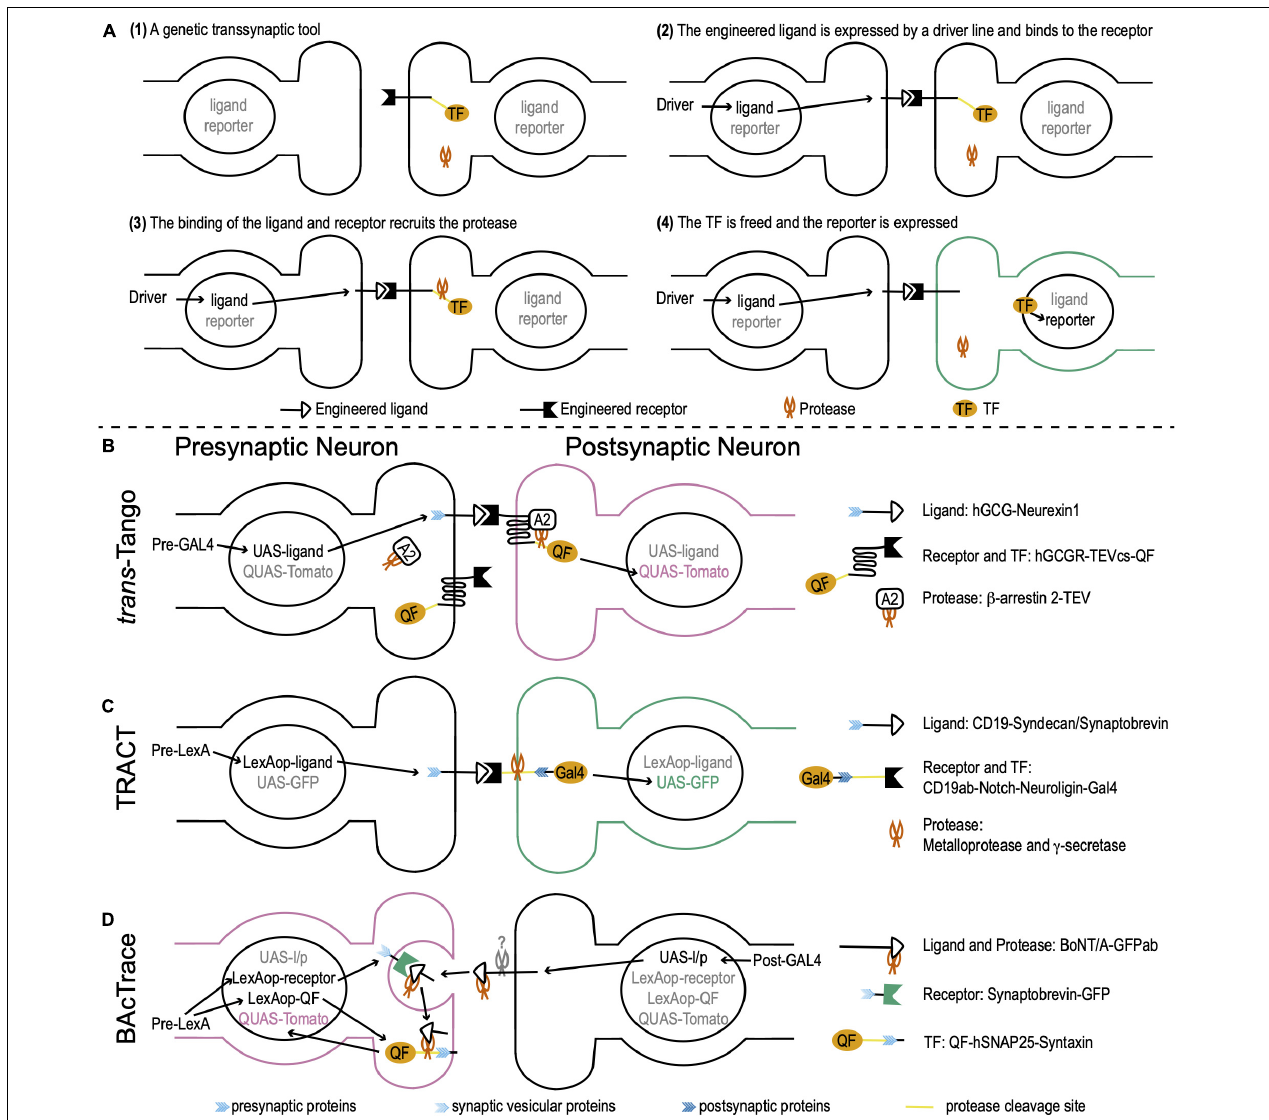
FIGURE 1 | Drosophila genetic transsynaptic techniques. (A) Schematic diagram depicting the principle and process of genetic transsynaptic tools. (1) A genetic transsynaptic tool often includes five components: an engineered receptor, an engineered ligand, a protease, a transcription factor (TF), and a reporter. (2) When a genetic transsynaptic tool is applied, a driver line for neurons of interest drives the expression of the engineered ligand. (3) The ligand binds to the engineered receptor on synaptically connected neurons and recruits the protease. (4) TF is freed and translocates to nuclei, where it activates the expression of the reporter to label synaptic partners. (B) trans- Tango. The receptor is hGCGR. The ligand is hGCG. The ligand is linked to Drosophila neurexin 1 (blue feather) for the presynaptic localization. The protease is TEV. It is tethered to β -arrestin 2 (A2) ( β -arrestin 2-TEV). The TF is QF. QF is tethered to the C terminus of receptor by a cleavage site of TEV (TEVcs) (yellow line). The reporter is Tomato that is controlled by QUAS ( QUAS-Tomato ). The receptor, TF, and protease are panneuronally expressed (the DNA information is not shown), while the ligand is controlled by UAS ( UAS-ligand ). Activation of trans- Tango requires a presynaptic GAL4 ( Pre-GAL4 ). (C) TRAnsneuronal Control of Transcription (TRACT). The receptor includes a CD19 antibody (CD19ab), the Notch regulatory region and transmembrane domain (yellow line), and the cytosolic domain of Drosophila neuroligin (dark blue feather) for postsynaptic localization. The ligand is CD19, whose C terminus is linked to the cytosolic domain of either syndecan or synaptobrevin (blue feather) for presynaptic localization (CD19-Syndecan/Synaptobrevin). The proteases are ubiquitously present metalloprotease and γ -secretase (the DNA information is not shown). They cleave the receptor at the Notch regulatory region and transmembrane domain. The transcription factor (TF) is GAL4 that is tethered to the C terminus of the receptor. The reporter is GFP controlled by UAS ( UAS-GFP ). The receptor and TF are panneuronally expressed (the DNA information is not shown; this fusion protein is linked to a postsynaptic protein and thus is not shown in the presynaptic terminal) and the ligand is controlled by LexAop ( LexAop-ligand ). Activation of TRACT requires a presynaptic LexA ( Pre-LexA ). (D) BAcTrace. The receptor is a fusion protein, in which a GFP is linked with Drosophila synaptobrevin, a vesicular protein in presynaptic terminals (light blue feather) (Synaptobrevin-GFP). The ligand is engineered from BoNT/A, whose receptor-binding domain is replaced by a GFP antibody (GFPab). The protease is the light chain of BoNT/A. The TF is QF. QF is linked with hSNAP25 (yellow line), the cleavage site of the light chain protease. This fusion protein is targeted to the presynaptic membrane by Drosophila presynaptic syntaxin (blue feather) (QF-hSNAP25-Syntaxin). The reporter is Tomato controlled by QUAS ( QUAS-Tomato ). The ligand/protease is controlled by UAS ( UAS-l/p ), while the receptor and TF are controlled by LexAop ( LexAop-receptor and LexAop-QF ). Activation of BAcTrace requires a postsynaptic GAL4 ( Post-GAL4 ) and a presynaptic LexA ( Pre-LexA ).